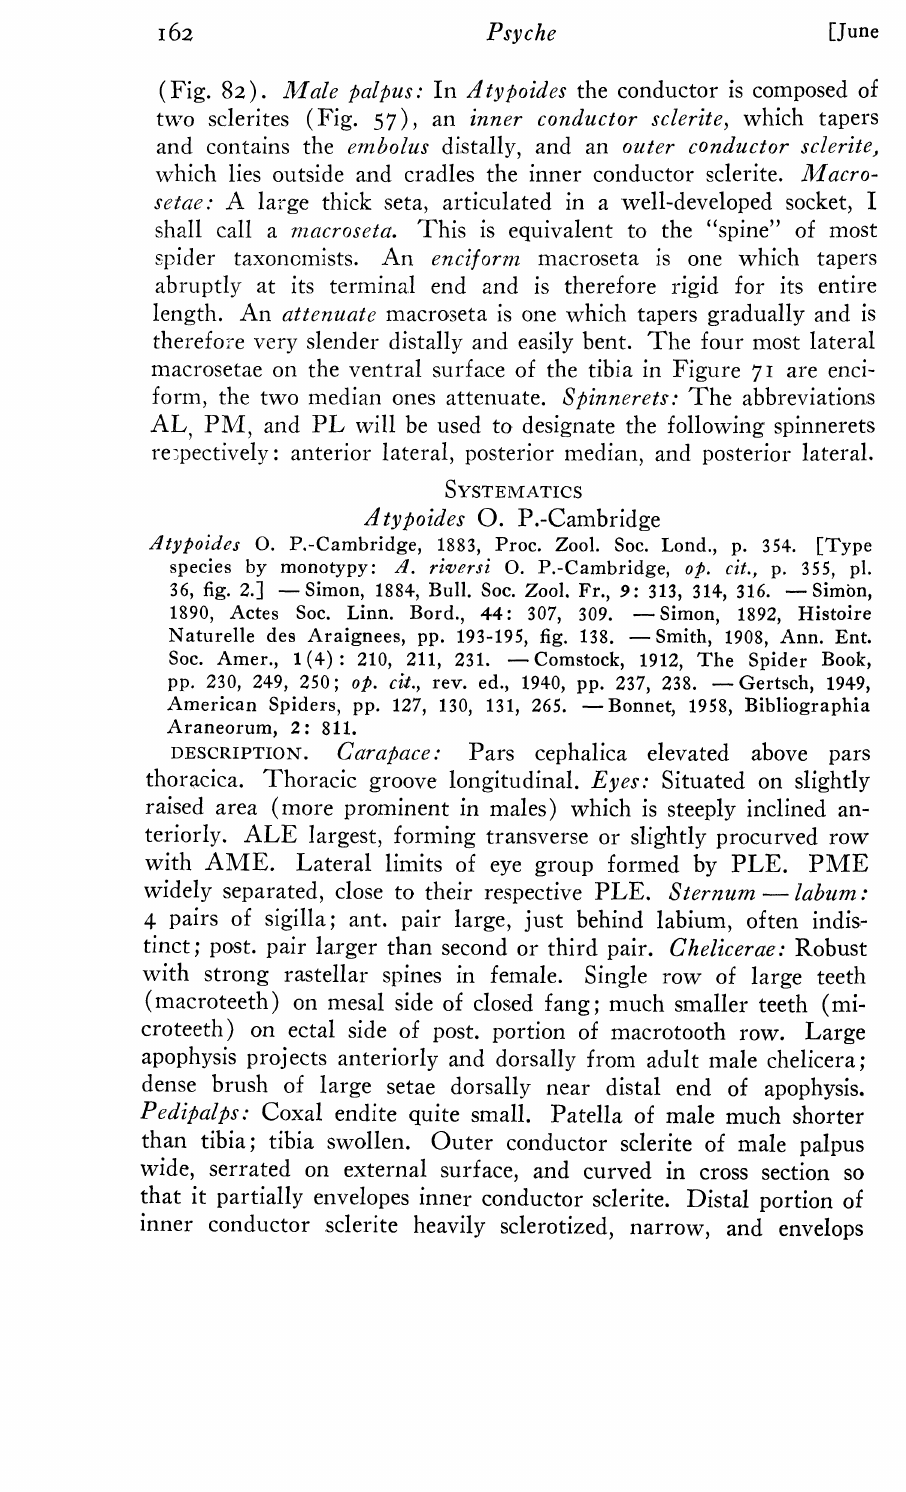
(Fig. 82). Male palpus: In A typoides the conductor is composed of two sclerites (Fig. 57), an inner conductor sclerite, which tapers and contains the embolus di.stally, and an outer conductor sclerite, which lies outside and cradles the inner conductor sclerite.